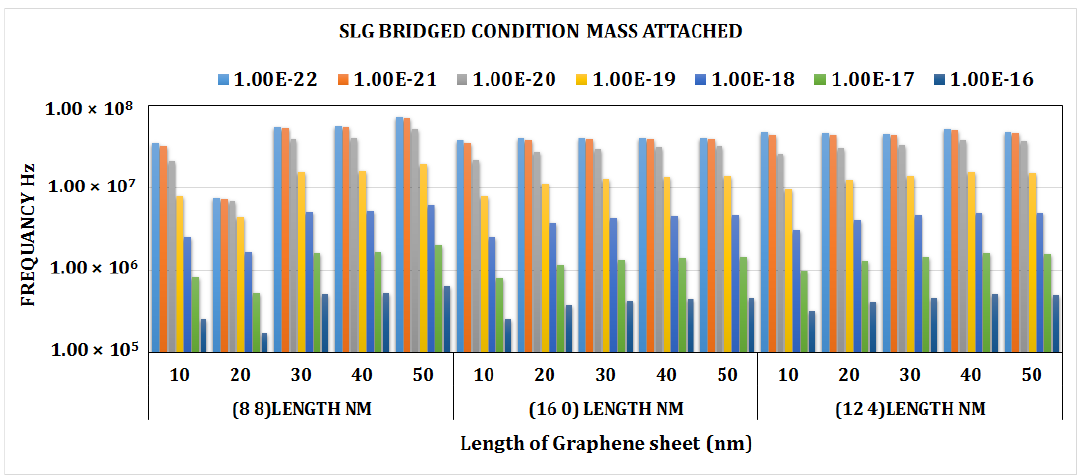
Figure 12. Frequency shift vs. length of graphene sheet of chiral, armchair, and zigzag cantilever SLG.